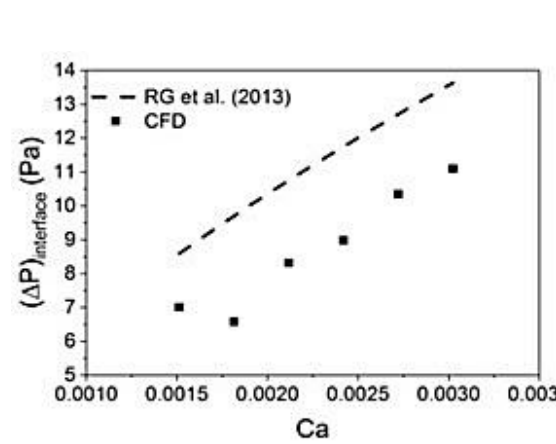
Figure 9. Comparison of the interfacial pressure drop as a function of Capillary number between the present CFD results and that obtained from Eq. (7) dodecane-water system